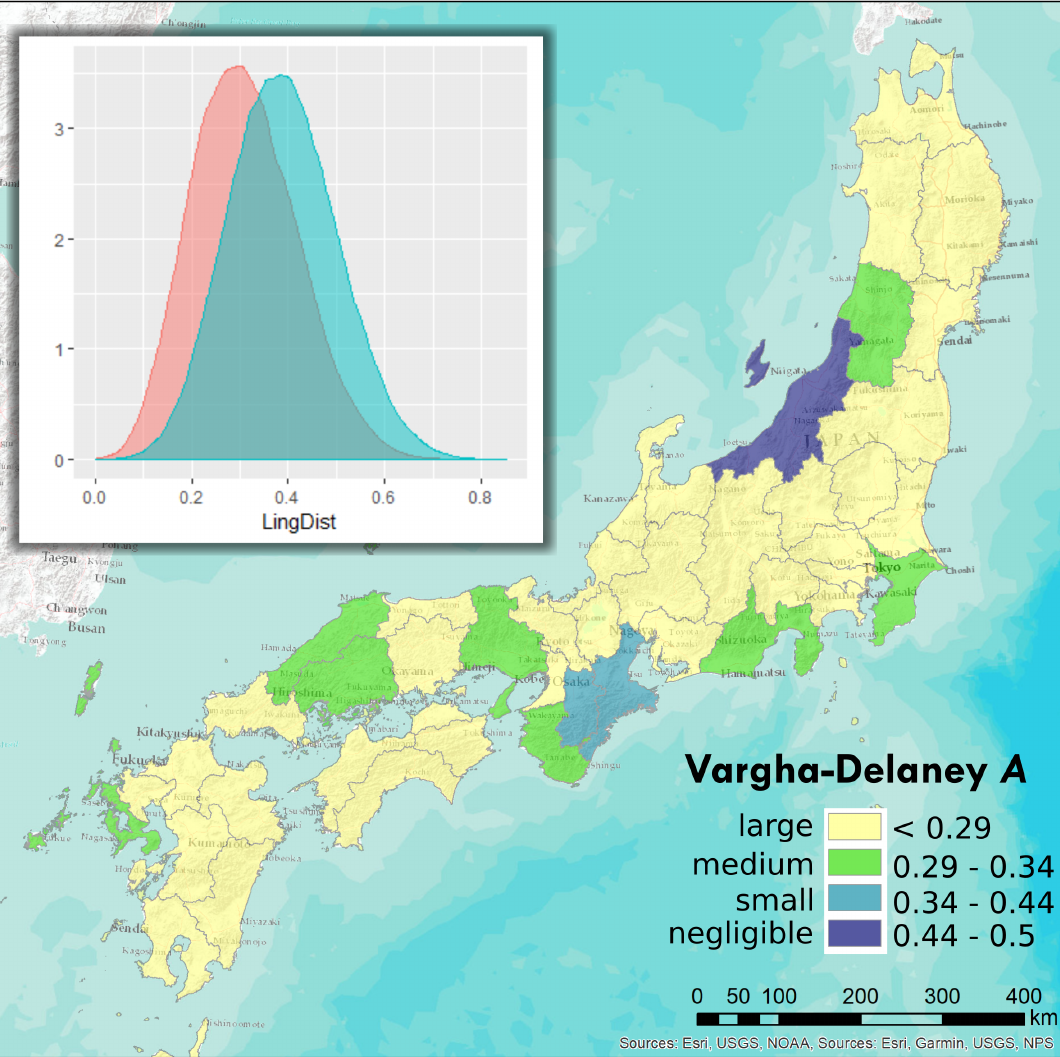
Figure 12. Map of the prefectural boundaries’ effect size categories on dialectal variation. The density plot shows the distributions of linguistic distances in the cumulated within (pink) and separated (blue) group, at the global scale. Distance cut-off: 150